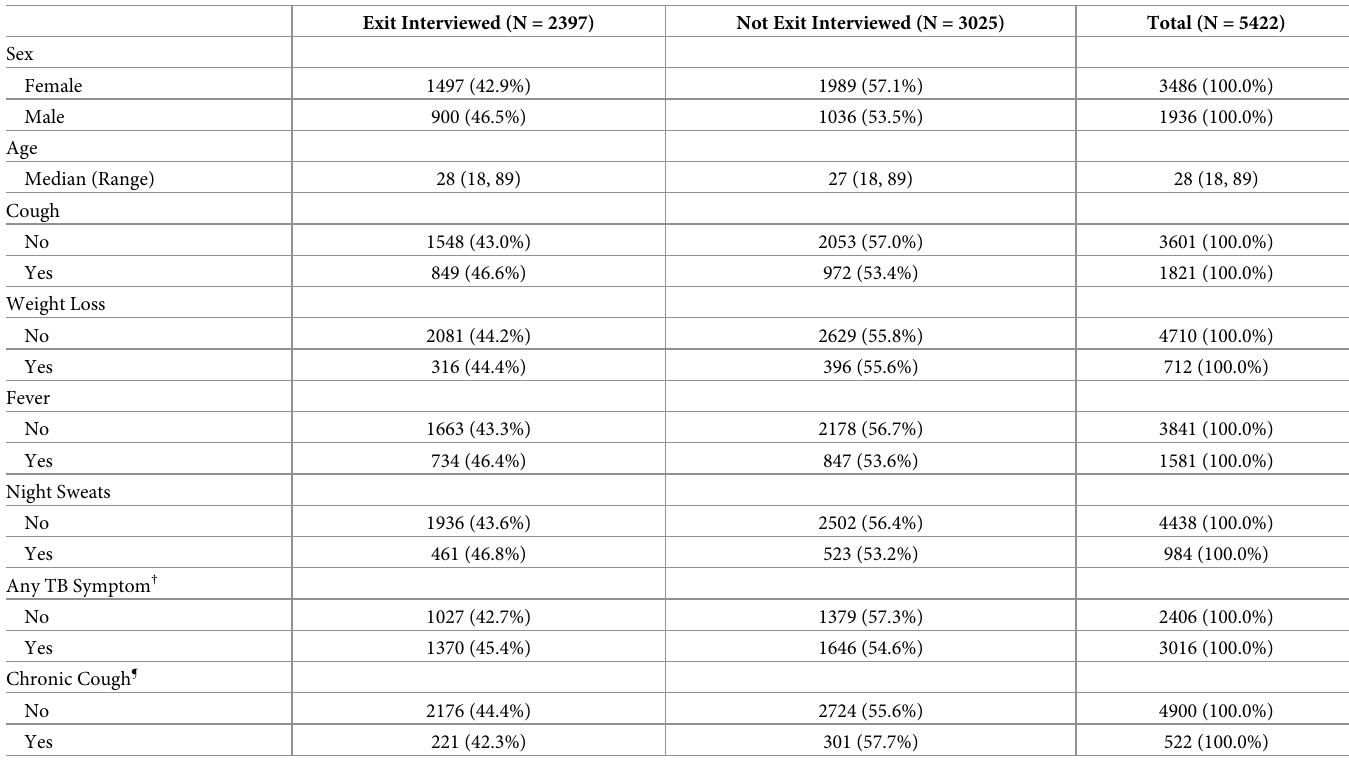
Table 1. Characteristics of adult acute clinic